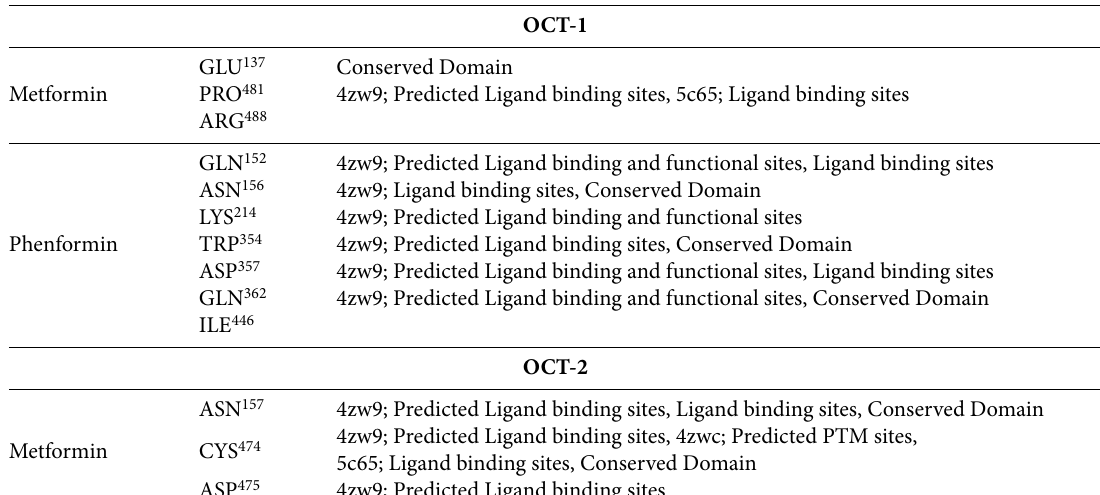
Table 1. The list of the results of the sequence features analyzing multiple alignments. The residues of OCT 1-3 proteins that interact with metformin, phenformin, and norepinephrine and functional annotations of template proteins from PDBe-KB. Exported Functional Annotations of the templates proteins from